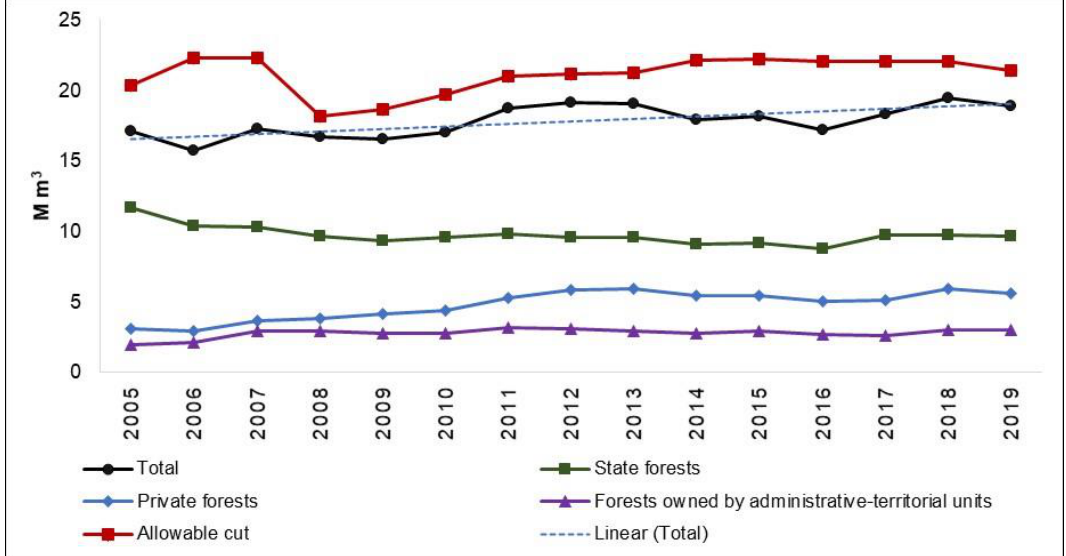
Figure 6. Dynamics of legally harvested wood volume and the allowable cut in 2005 – 2019 (data source: [81]). source: